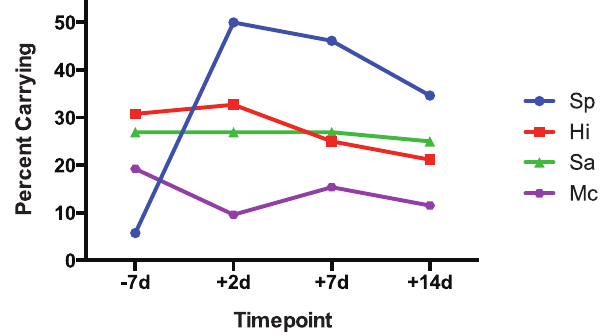
Figure 2. Percent of subjects carrying Sp, Hi, Sa, and Mc at baseline and at 2, 7, and 14 days post-inoculation. Nasopharyn- geal samples from 52 subjects were examined at four time points for bacterial DNA and carriage was defined as . 100 genomes/ml.